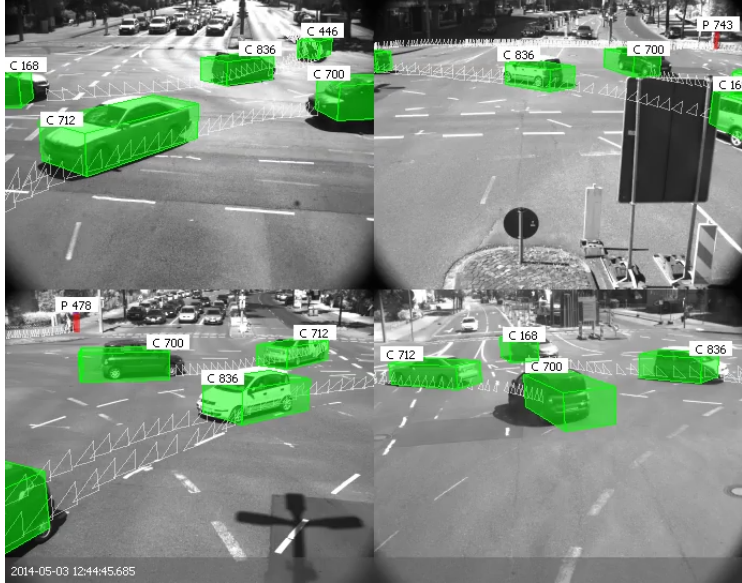
Figure 4: Visualization of a given traffic scene from the four MSS perspectives with augmented object